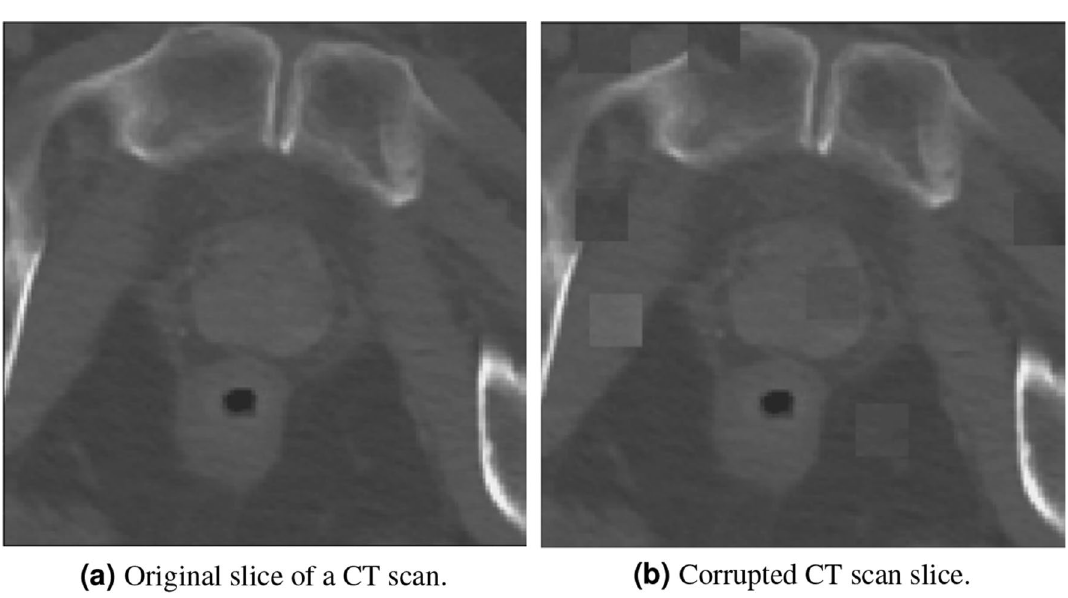
Figure 4. Examples of a single slice from the patch swap reversal pretext